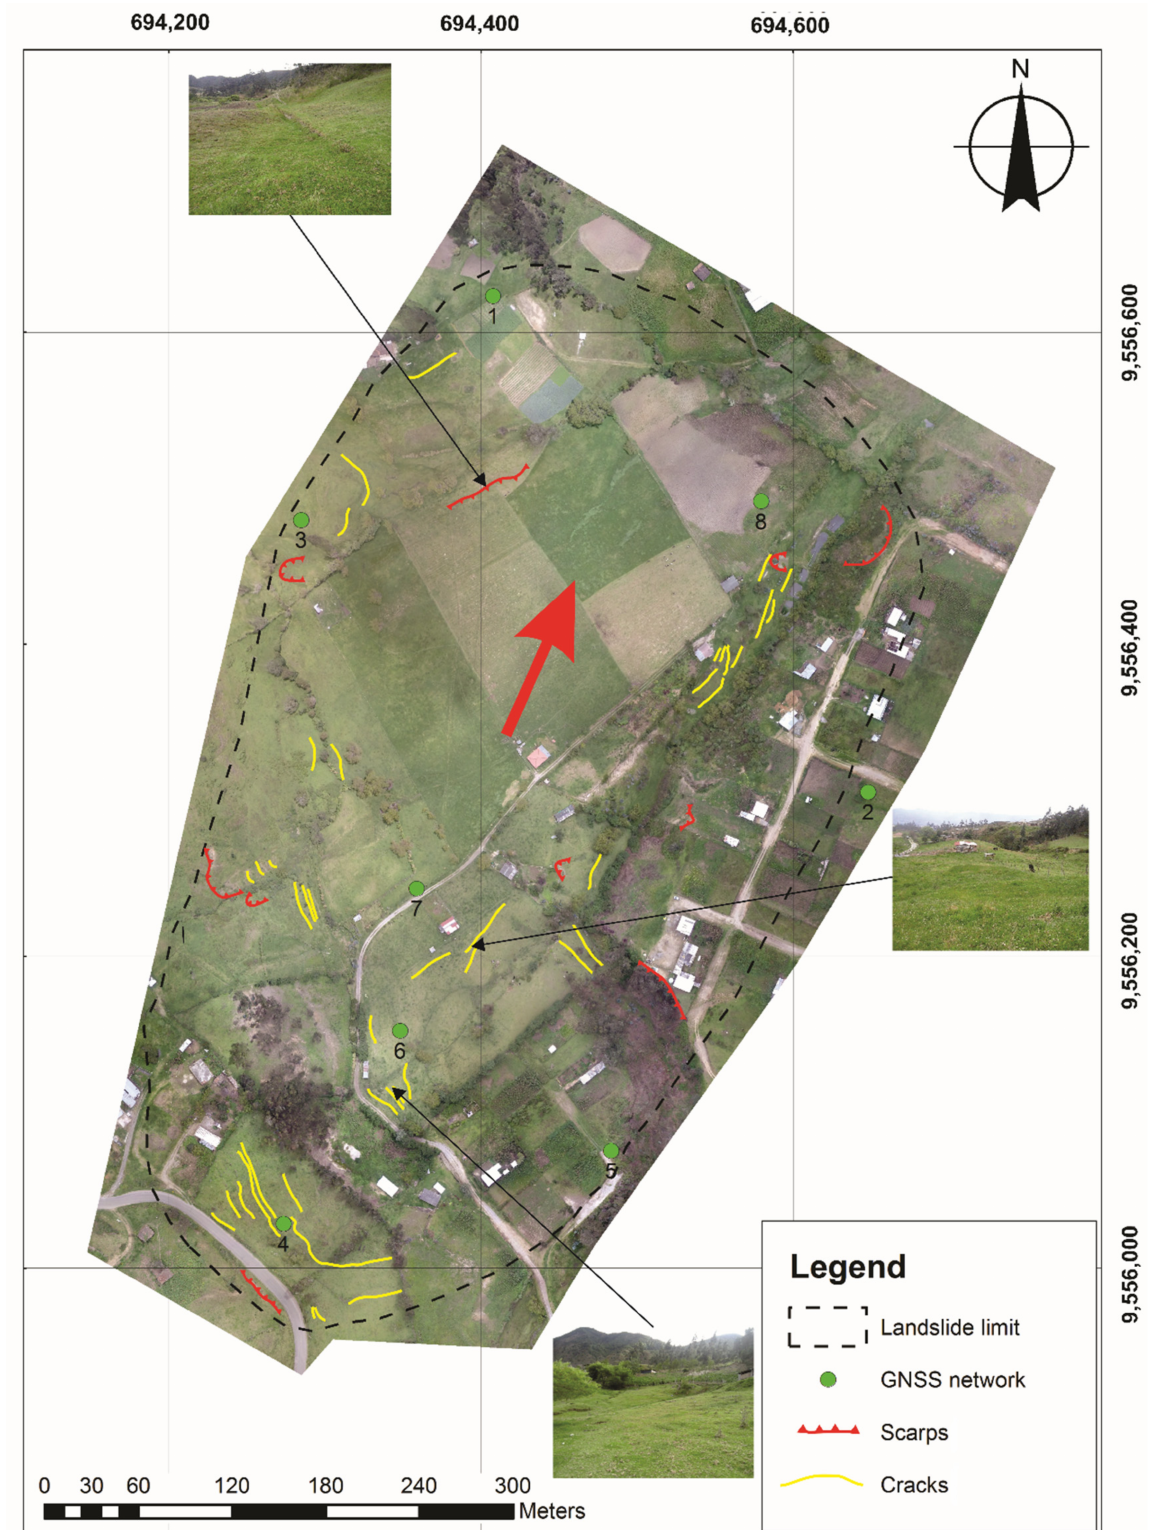
Figure 2. Geomorphological evidence of the landslide in the Victoria study area (photograph February 2016). The Colinas Lojanas study area is located on the Quillollaco Formation, which has four lithologies: conglomerates, clays, sands, and limonites. The conglomerates are the predominant rocks in the Quillollaco Formation that outcrop in natural and